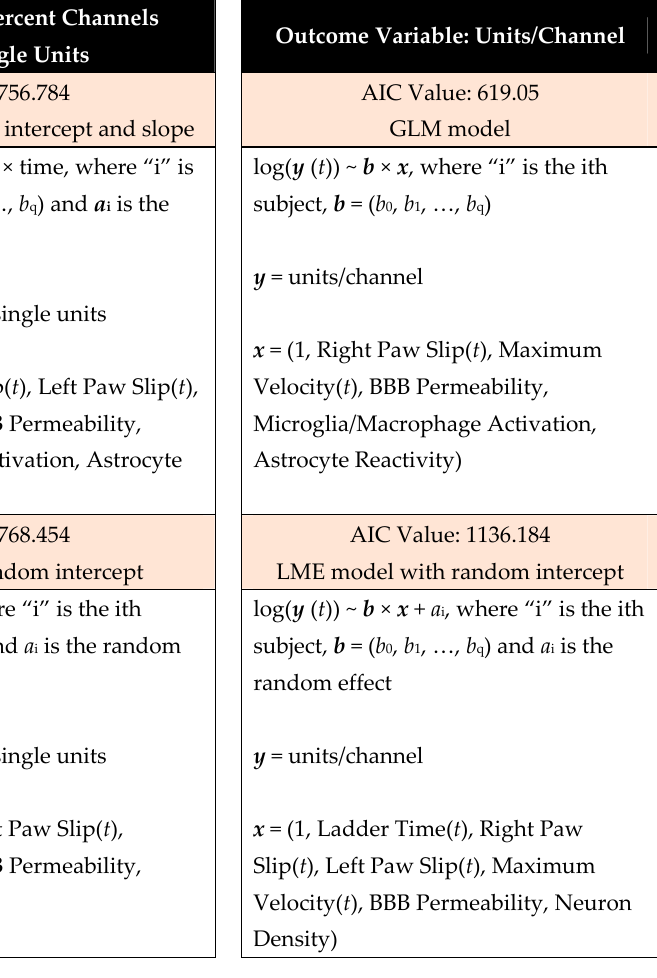
Table 1. Details of the regression analyses models. The formulas depict the relationships between the longitudinal versus single time point variables. Although there were only n = 6 animals, there was a total 480 observations for the “ y ” recording outcome variables, 54 observations for the “ x ” behavior variables, and 6 observations for each of the “ x ” histology variables per distance interval.